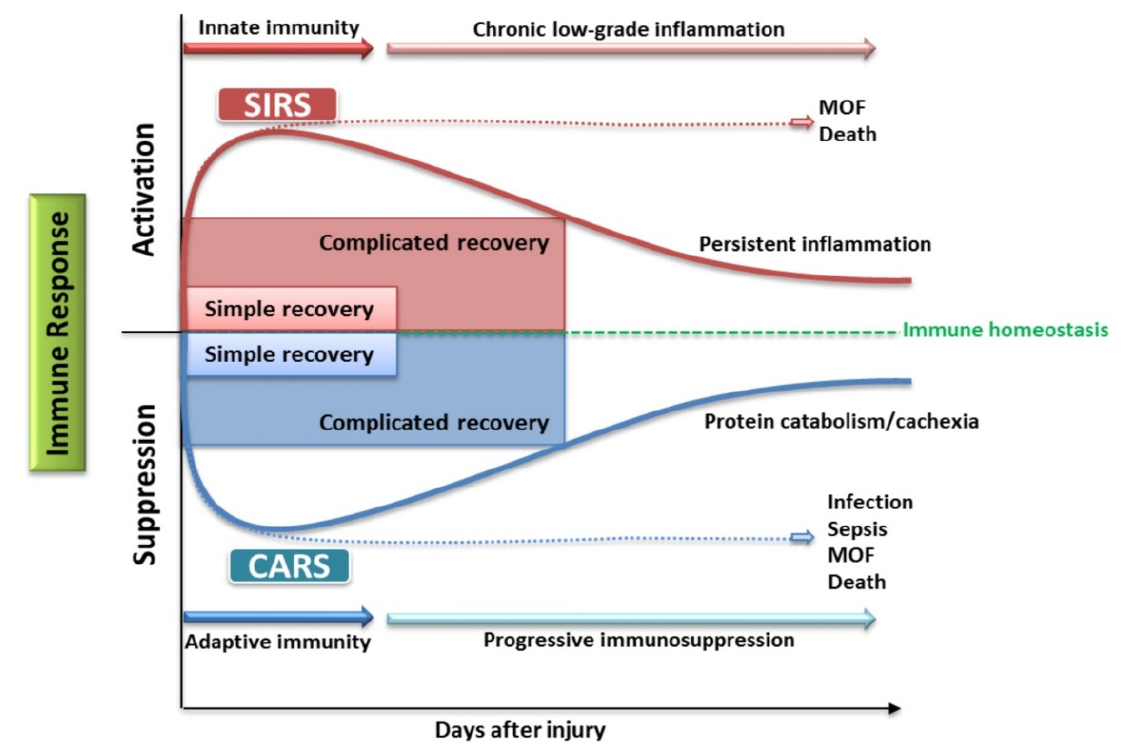
Figure 3. Importance of maintaining immune homeostasis in burns based on [59,60].